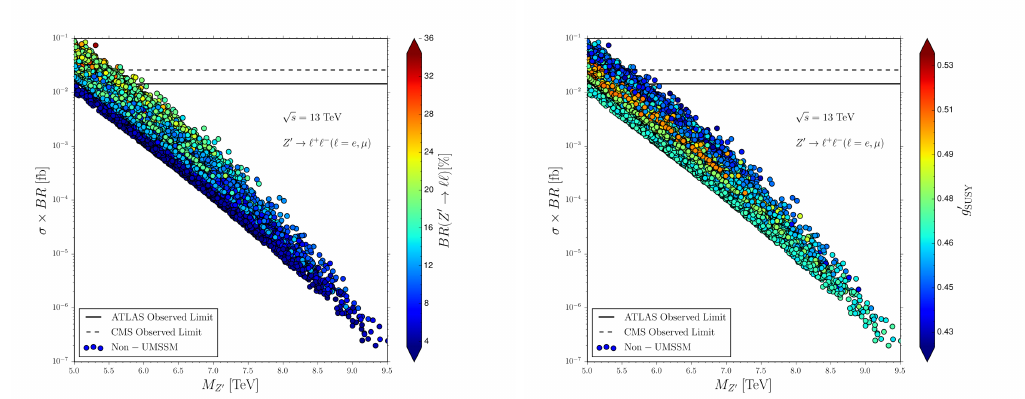
Figure 7 . Z 0 mass limits in the non-universal U(1) 0